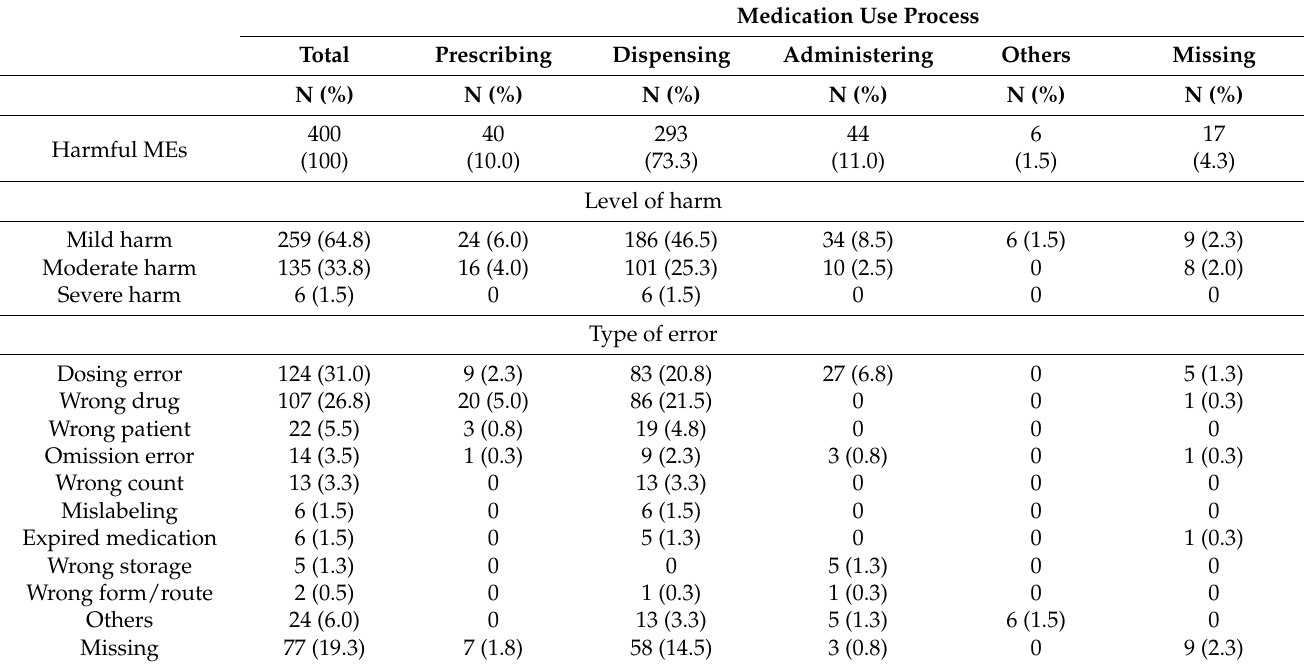
Table 2. Level of harm and type of errors of harmful medication errors by medication use